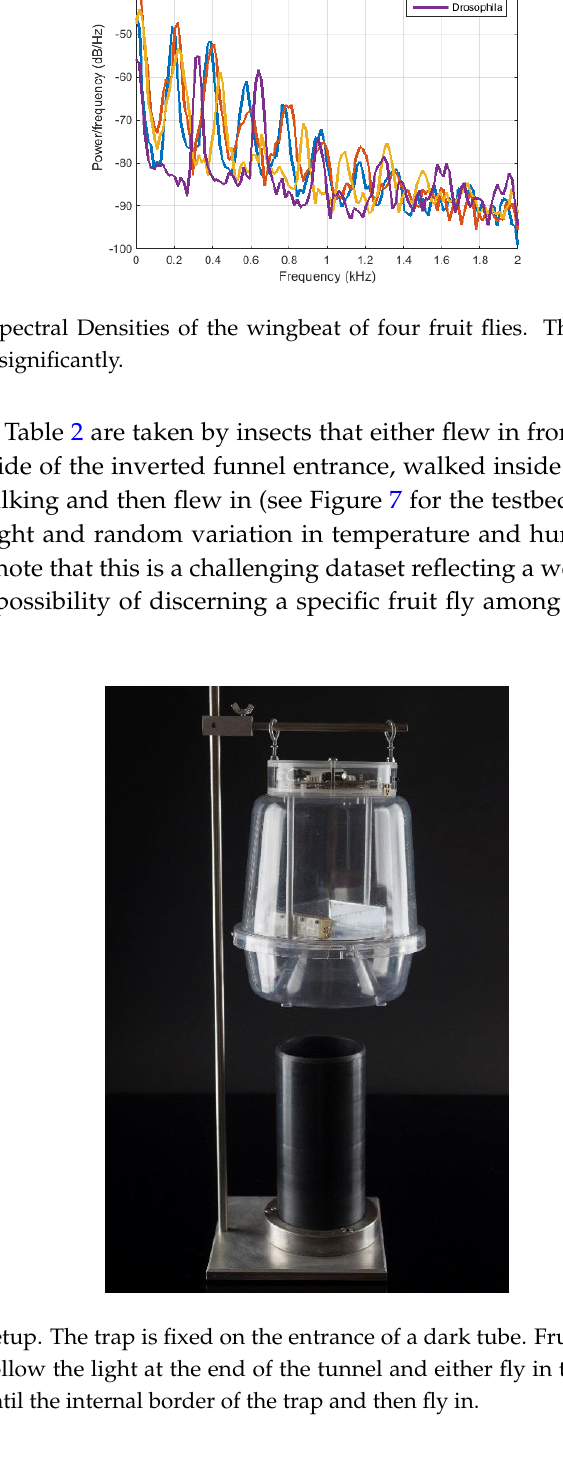
( b ) Figure 5. ( a ) Optical recording of different cases of B. oleae flying in the trap. High-frequency modulation due to wingbeat and low-frequency main-body movement; ( b ) spectra of the corresponding recordings. The fundamental frequency is at around 200 Hz and at least five harmonics are resolved. 3.1. Verification Results in the Lab Verification involves answering a problem with a binary answer: once the device is triggered, due to detection of an entering insect, the question is whether then becomes was it the target species ( i.e., B. oleae in our case ) that flew in or not. We are not interested in the context of this work to recognize any species other than the target pest. Two approaches were examined: (a) a simple, rule-based approach that reports results based on calculations carried out inside the trap, and (b) results based on analyzing off-line the stored recordings. The first approach is based on two simple rules that simultaneously must hold in order to count a signal as a target case: Rule 1 : Examine if the amplitude of the time domain recording is within the limits derived from a large number of B. oleae recordings (see Figure 5). Insects that have larger wings than B. oleae will return a larger